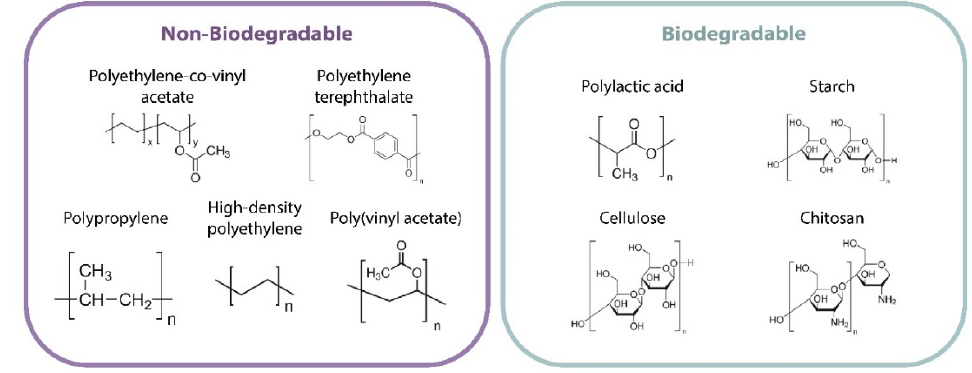
Figure 4. Chemical structures of the nonbiodegradable and biodegradable polymers most frequently used in the active food packaging industry.